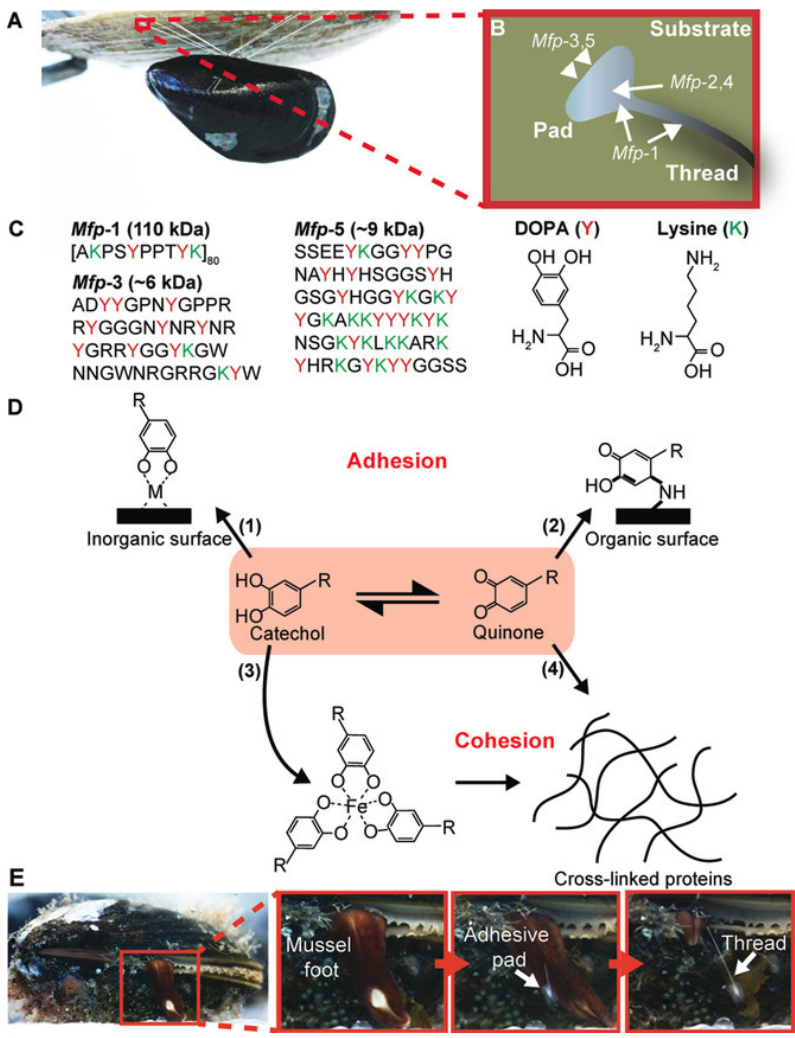
Figure 3. ( A ) Blue mussel attached to a solid substrate (another mussel shell) using its byssal threads. Photo credit MSc Simon Frølich (Aarhus University). ( B ) Biodistribution of mussel foot proteins (mfps) in the byssal thread and pad. ( C ) Primary amino acid sequence of mfp-1, mfp-3 and mfp-5 (Y: DOPA, K: lysine). ( D ) Scheme showing examples of the adhesive and cohesive properties of catechol-containing proteins, R represents the remainder of the mfps. ( E ) Time-lapse photography showing the molding of a byssal thread (molding time ≈ 5 min). Reproduced from [47] with permission. Copyright 2016 WILEY-VCH Verlag GmbH & Co. KGaA, Weinheim.